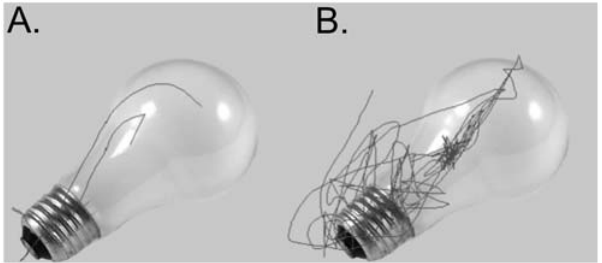
Figure 2. Example Scanpath. When no visuomotor transformation was required, aged participants (B) engaged in more scanning of the presented object than did young controls (A).